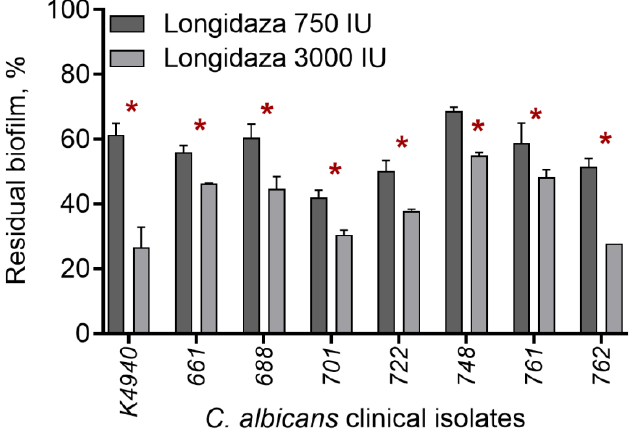
Figure 2. The in vitro destruction of biofilms formed by C. albicans clinical isolates. Forty-eight-h-old C. albicans biofilms were washed and incubated 24 h in fresh BM broth supplemented with 750 IU or 3000 IU of Longidaza ® . Biofilms were quantified with crystal violet staining. Asterisks denote significant difference with untreated samples (* p < 0.05). Table 2. Comparative assessment of the total biomass of biofilms and the relative content of poly- saccharides and proteins in the matrix of biofilms of C. albicans isolates before and after treatment with Longidaza ® .